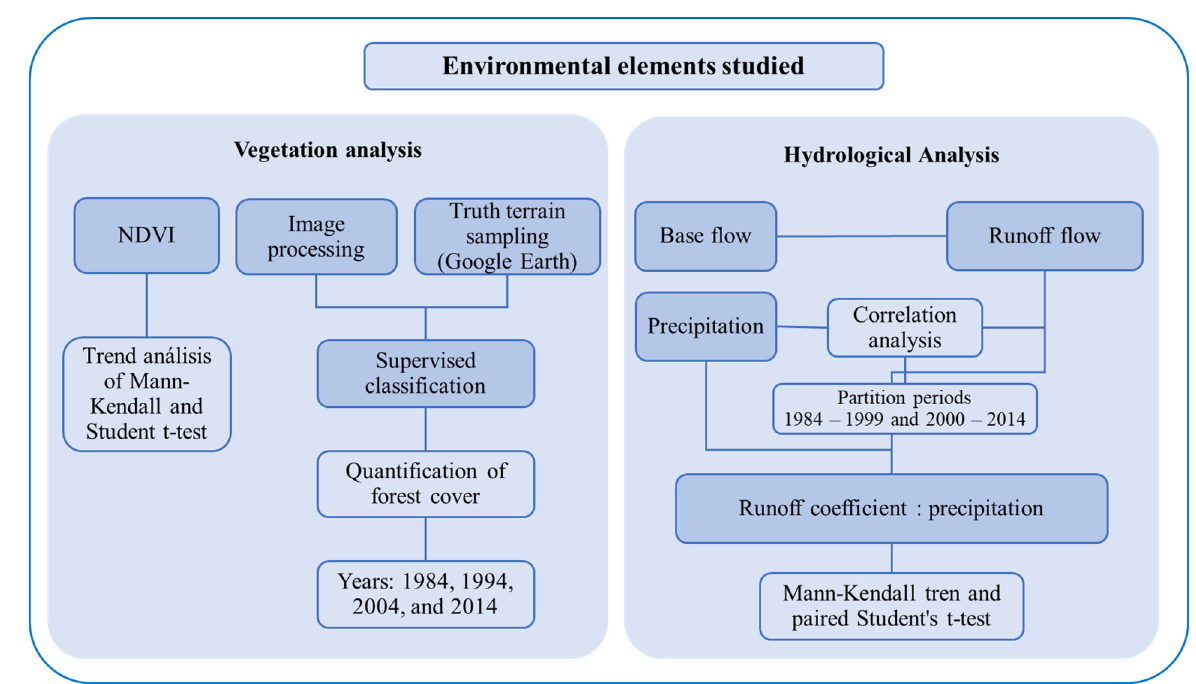
Figure 2. Diagram of the environmental elements studied.